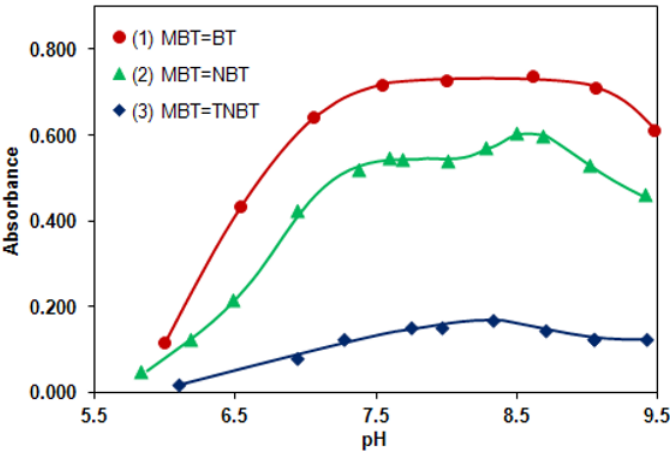
=1×10 −5 mol L −1 , C =C = In(III) PAR MBT